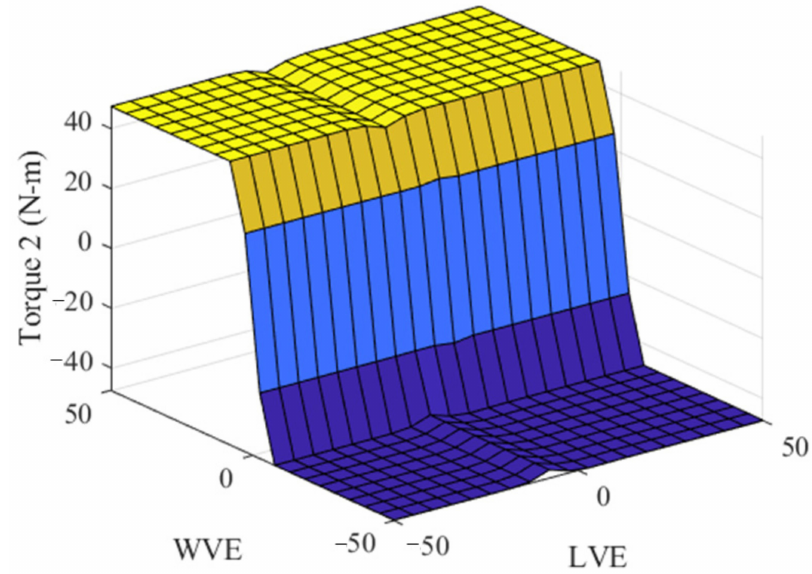
Figure 9. Torque 2 surface.